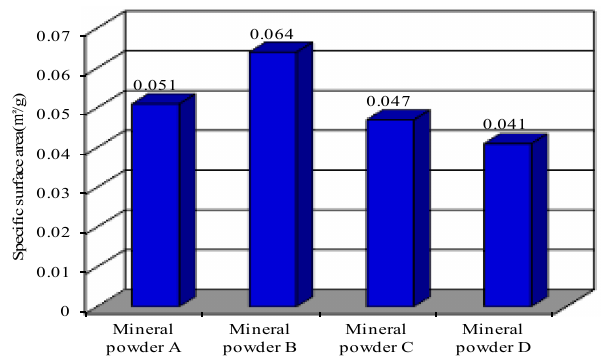
Figure 4. Difference in specific surface area of the four kinds of the mineral powder.